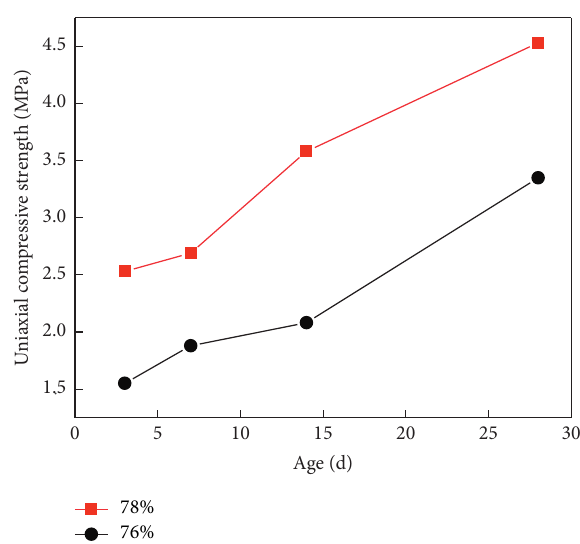
Figure 8: Variation in filling strength with age at different